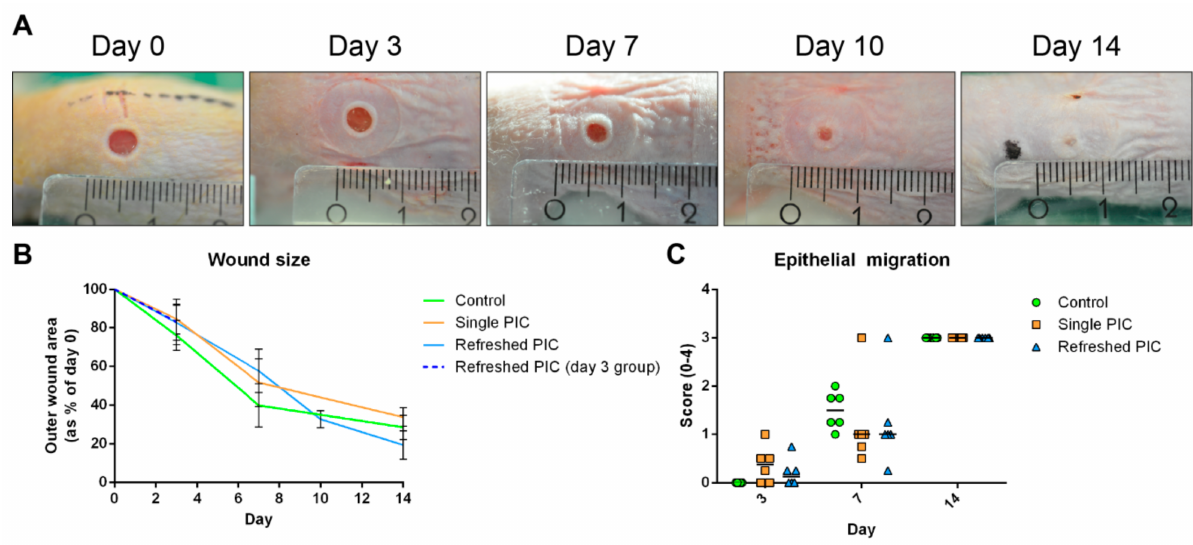
Figure 3. Wound size and the migration of epithelium. ( A ) This photo series shows the closure of the left wound on a mouse from the day 14 refreshed PIC group (smallest ruler increments in millimeters). The wound closes, and epithelium migrates between days 7 and 14. ( B ) Quantifying the outer wound sizes using ImageJ on photographs (error bars represent standard deviations). The day 3 refreshed PIC group is depicted separately, as the protocol deviated slightly from the other time points. PIC-treated wounds were significantly larger on day 7, whereas refreshed PIC wounds were significantly smaller on day 14. ( C ) Migration of epithelium was scored on HE-stained sections and typically initiated between days 3 and 7 (horizontal lines represent the medians). By day 14, all wounds were closed, and keratinization had taken place. No hypertrophic wounds were